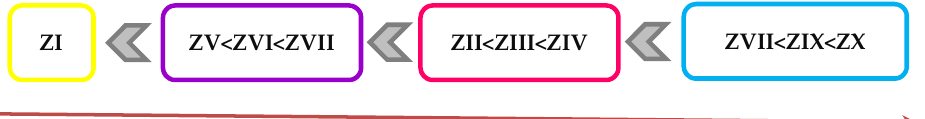
Figure 13. Transformations accompanying the leaching reaction of calcium ions (Ca 2+ ) from cement–ash mortars in the environment of aggressive solutions of acids (HCl, H 2 SO 4 and HNO 3 ) under the influence of the disodium versenate indicator Na 2 H 14 C 10 O 8 N 2 ∙H 2 O.